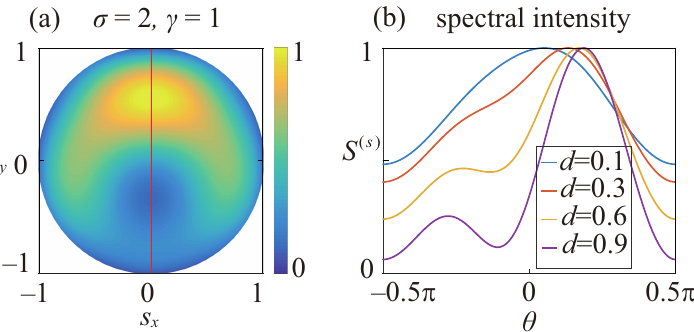
Figure 7. ( a ) Simulation results for the effect of spatial coherence of incident beam on the total intensity of far-zone scattered field generated by scattering the partially coherent radially polarized beam having degree of coherence shown in Equation (39) with a four-point scatterer having PT- symmetric potential ( σ = 2 and γ = 1). ( b ) shows the cross lines along s y direction. The spatial coherence is controlled by the factor d = β 1 = α 2 = β 3 .